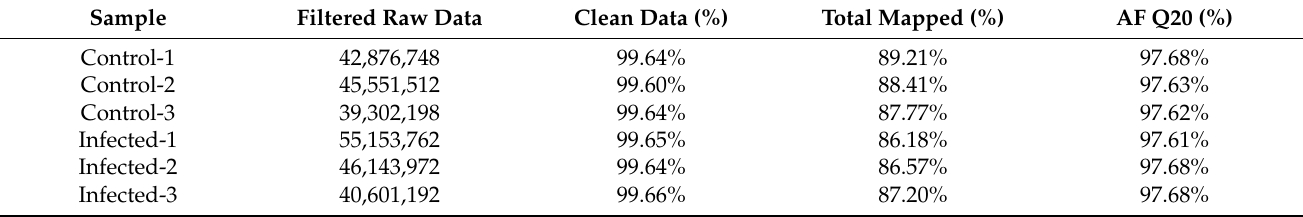
Table 1. Summary of the greenfin horse-faced filefish transcriptome assembly. Sample